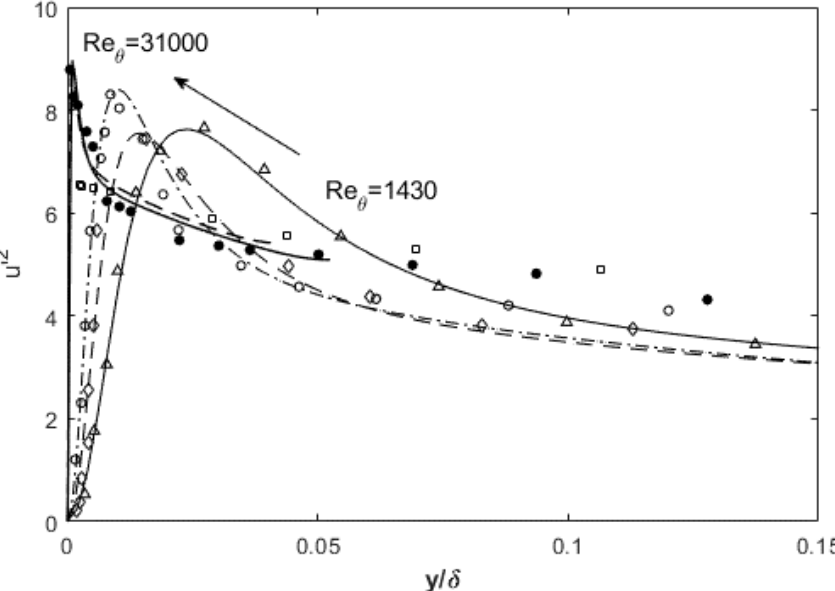
Figure 5. Reconstruction of flat-plate u’ 2 from a channel-flow template at Re τ = 300. The template is taken from DNS data of Iwamoto et al. [11], while experimental data are from deGraaf and Eaton [17].